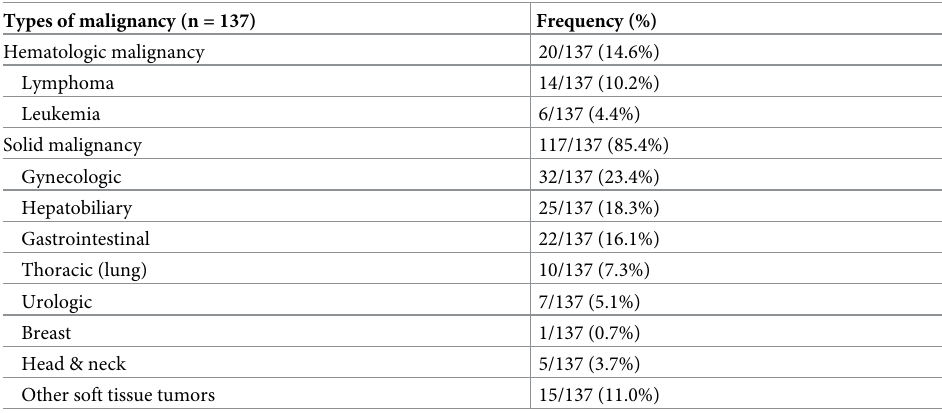
Table 2. Types of malignancy included in this